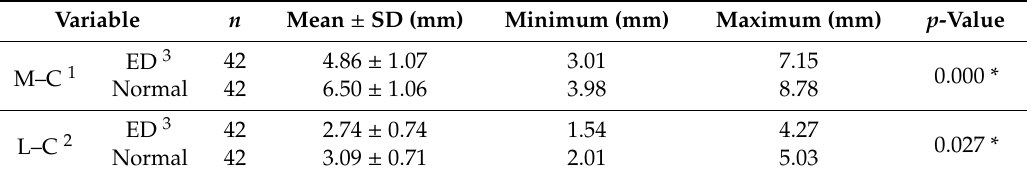
Table 3. Minimum, maximum, and mean measurements of distances from the center of the mandibular canal to the lingual and inferior cortices of the mandible.